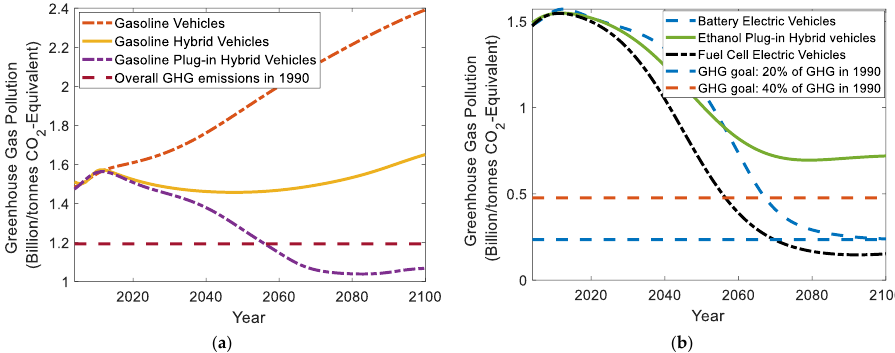
Figure 2. The greenhouse-gas (GHG) emissions by different technologies: ( a ) Gasoline-based vehi- cles and the overall GHG emissions in 1990, ( b ) Alternative-fuel-based vehicles and the overall GHG goals